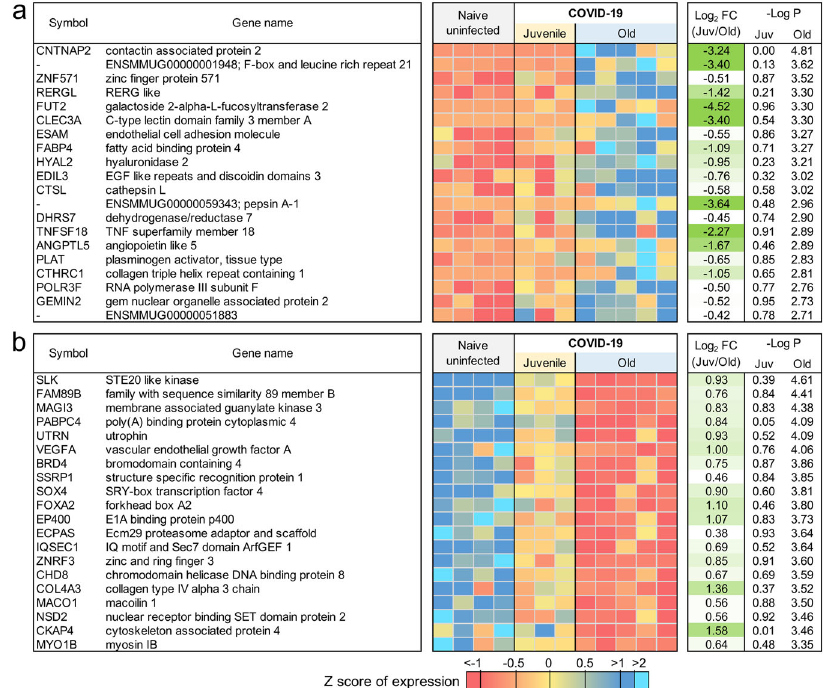
Fig. 6 Genes related to VEGF signaling are downregulated in old macaques compared to juvenile macaques during COVID-19. The top 20 most signi fi cantly a upregulated genes and b downregulated genes in infected old macaque lungs but not in juvenile macaques. Expression values are visualized by Z scores of normalized expression data (FPKM) per sample, and Log 2 fold change and -Log P values are from the DESeq2 output. Genes are sorted by P